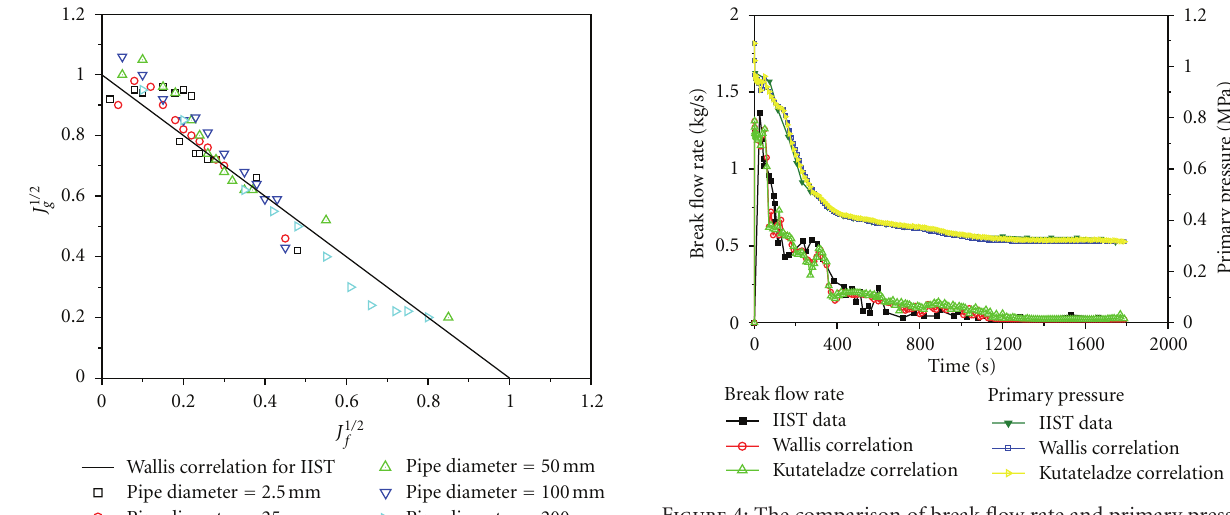
Figure 4: The comparison of break flow rate and primary pressure among Wallis form, Kutateladze form, and IIST data.